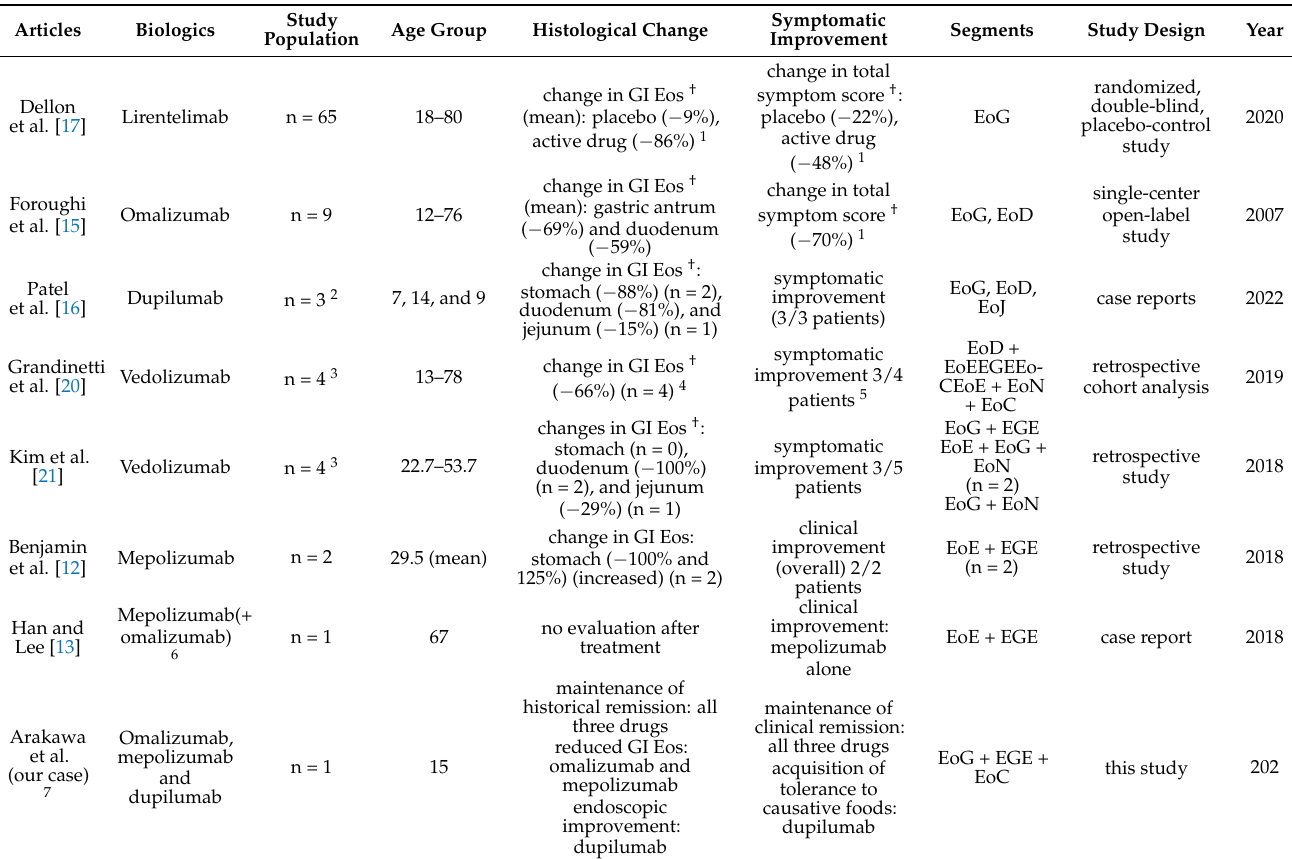
Table 2. Studies using biologics in non-EoE